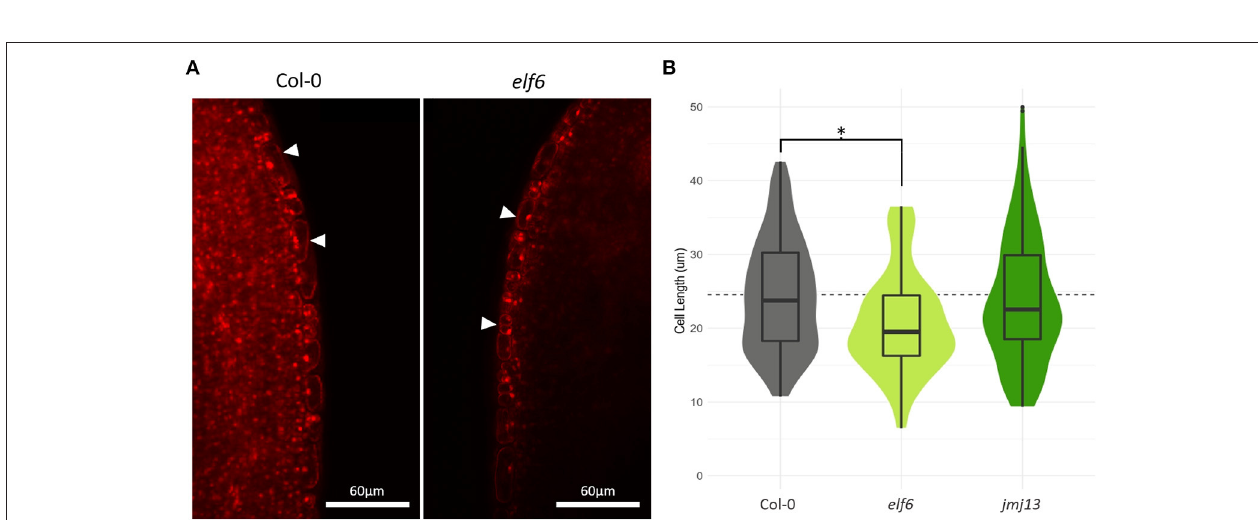
FIGURE 4 | Effects of elf6 knock-out on carpel epidermal cell length. (A) Confocal microscopy of stage 14 carpel mid sections using propidium iodide staining to highlight individual cells. The image on the left is taken from a Col-0 carpel, whilst the right hand image is from elf6. White arrow heads indicate the epidermal cell layer. Scale bar depicts 60 µ m. (B) Measurements of cell length in carpel epidermis. A significant 15% reduction in mean epidermal cell length was observed in elf6 carpels compared to Col-0 carpels ( n > = 3 carpels per genotype, n > = 95 cells measured per genotype, p < = 0.05, t -test). The dashed line represents the mean carpel epidermal cell length of Col-0 carpels. The asterisk denotes a significant change in cell length between the indicated genotypes ( p < = 0.05, t